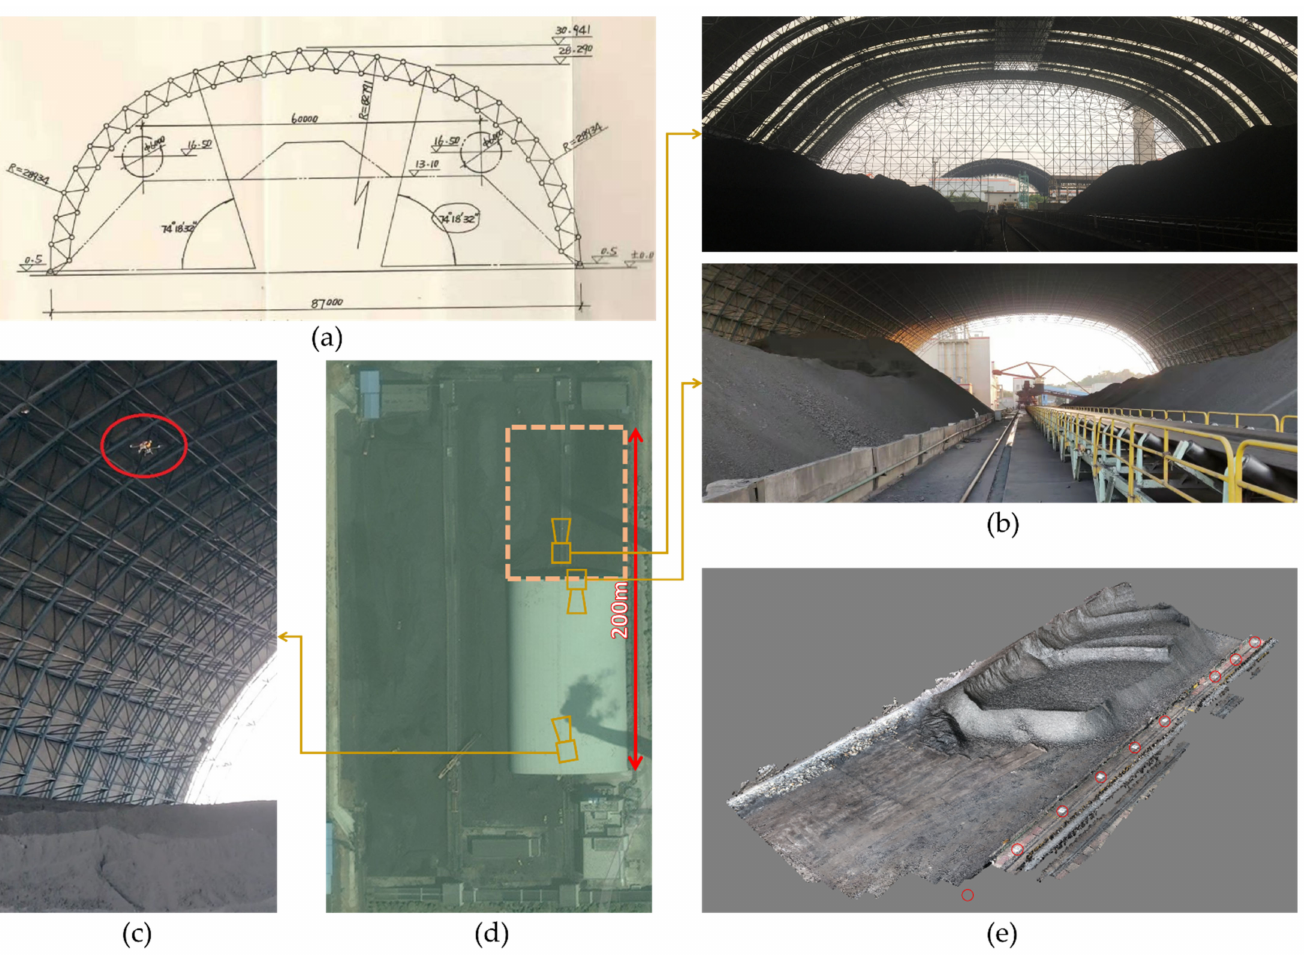
Figure 9. The test environment and test flight photo. ( a ) is the schedule drawing of dry coal shed roof. ( b ) is the site environment photo. ( c ) is the photo during the test flight. ( d ) is the satellite image of the dry coal shed. Although the square part is in the open air in the satellite image, the roof was built during the flight test. ( e ) is the three-dimensional map of the flight test site obtained by the visual three-dimensional mapping method irrelevant to this paper. The part circled in red is the global ArUco. Four markers near the takeoff point and on the sidewalk are not shown in the figure due to the scope of the